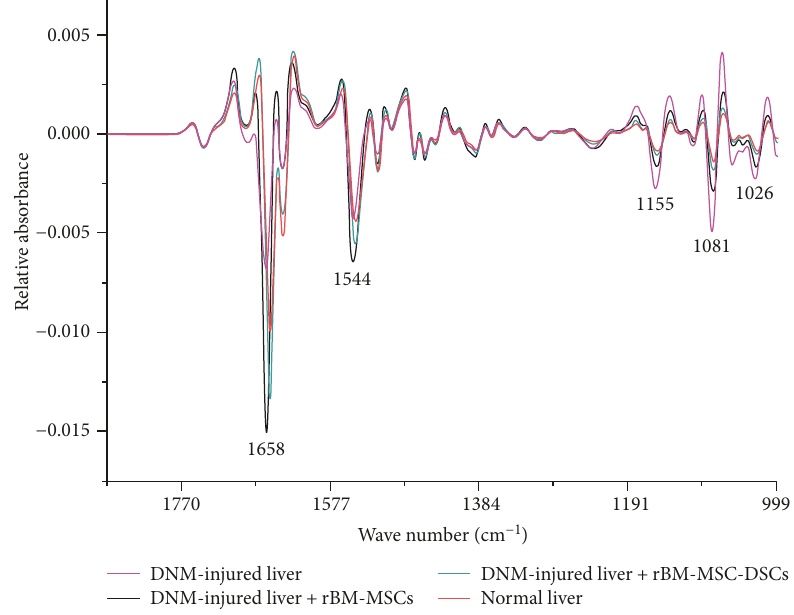
Figure 5: Average second derivative FTIR spectra from 1800 to 950cm − 1